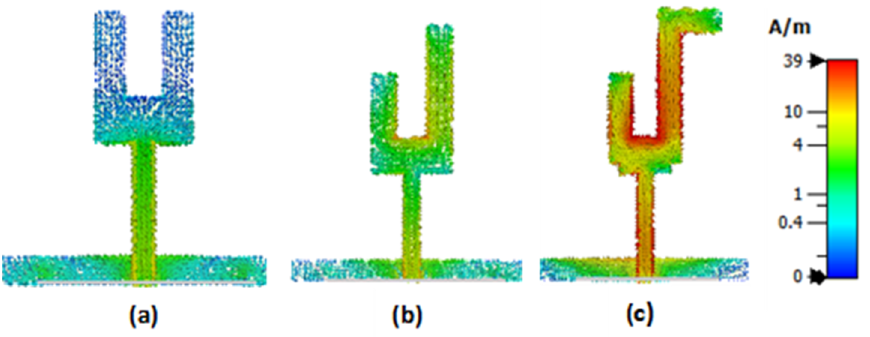
Figure 2. Distribution of surface current during antenna design evolution: ( a ) Initial design, ( b ) Modified design, and ( c ) Proposed design